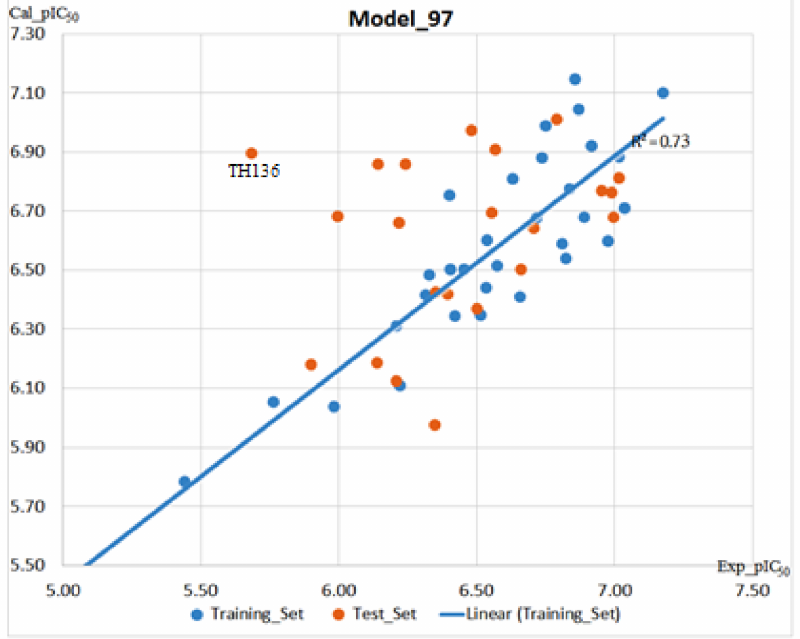
Figure 6. Correlation plot between the experimental pIC 50 values (X-axis) and the calculated pIC 50 values (Y-axis) for the training set molecules (blue points) using model 97 as well as the distribution of the newly designed set of molecules (orange points) along the linear regression